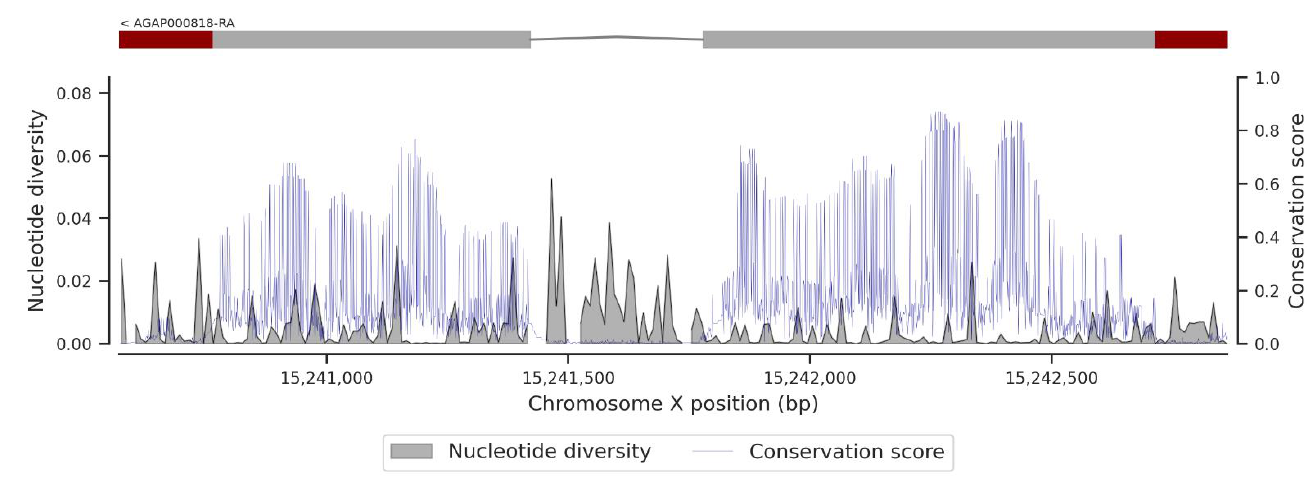
Figure A10. Conservation score and nucleotide diversity in a window of 12 bp within the Cyp9k1